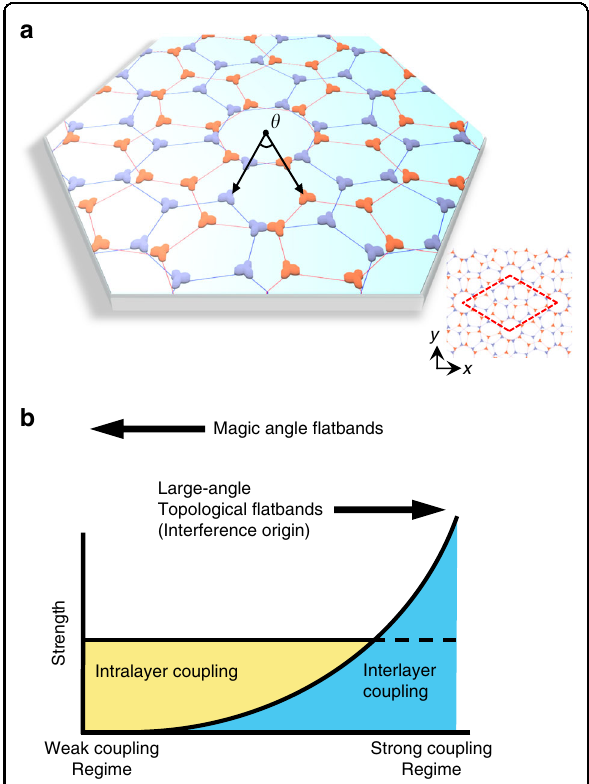
Fig. 1 Strongly coupled photonic moiré superlattices. a Picture of the photonic moiré superlattice. Two honeycomb lattices of dielectric resonator quasi-atoms (red and blue) are overlaid with twist-angle θ . The primitive unit cell in the right panel is marked with the red rhombus and contains 28 quasi-atoms. b Schematic illustration of the strong coupling regime of the moiré superlattice. As the interlayer couplings exceed the intralayer couplings, we fi nd topological fl at bands at large twist-angles. This feature is in direct contrast with the weak coupling regime, where fl at bands appear only at the magic angles. See sections S14 – 18 in Supplementary Materials for the tunability of the interlayer couplings as a function of the refractive index and the